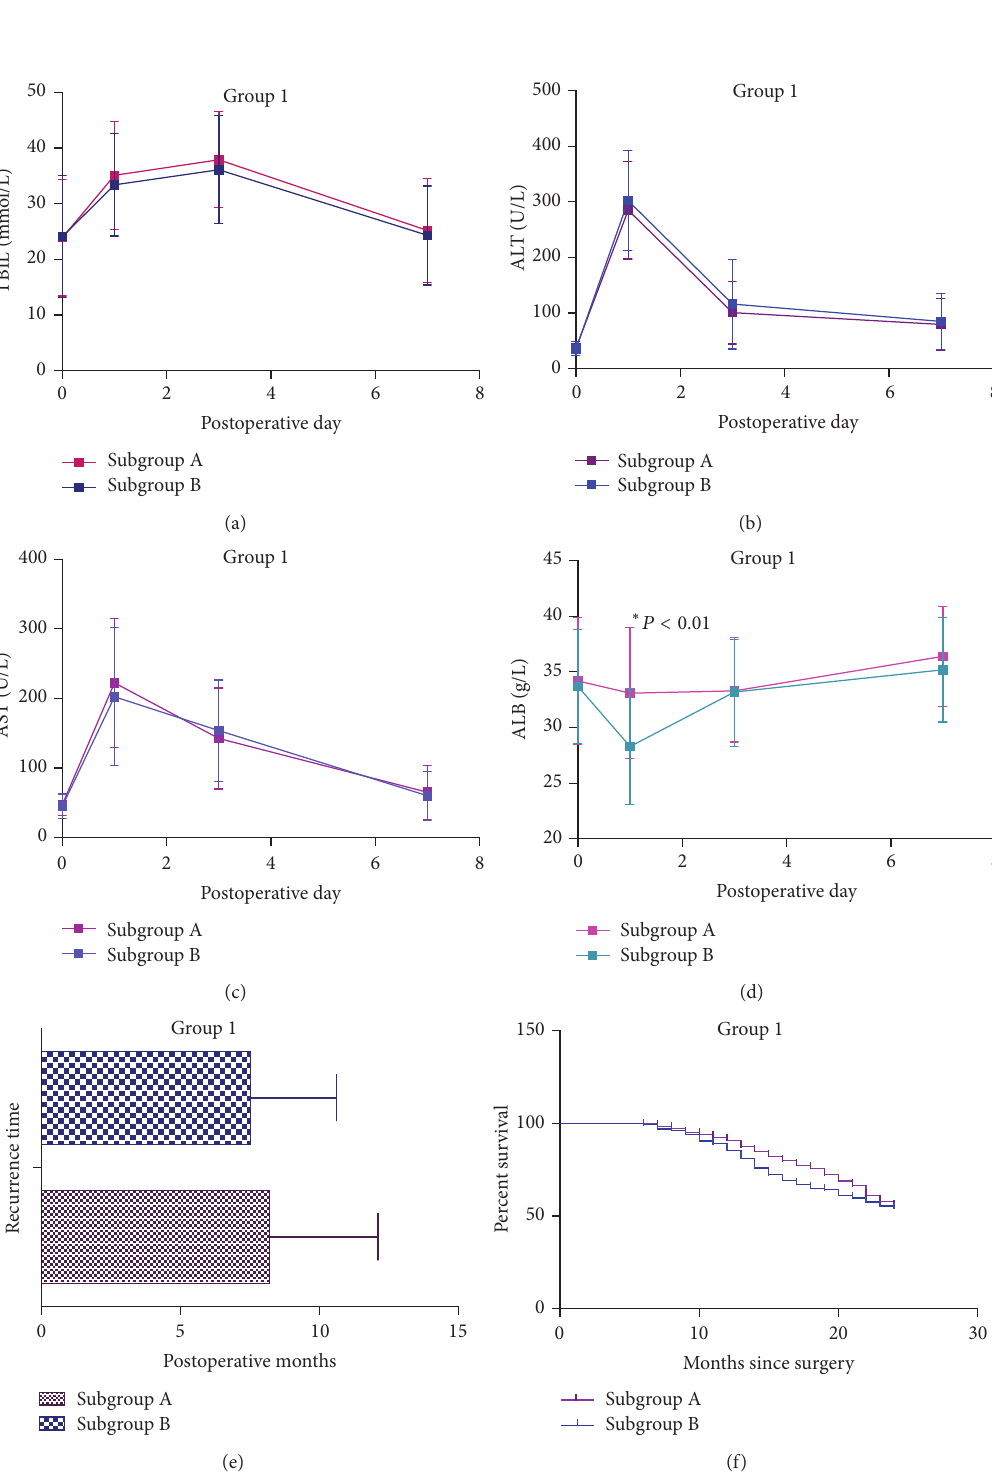
Figure 2: Curves of parametric data for patients in group 1 during the perioperative period and prognosis data. (a) Curves of TBIL levels in group 1 on postoperative days 1, 3, and 7. (b) Curves of ALT levels in group 1 on postoperative days 1, 3, and 7. (c) Curves of AST levels in group 1 on postoperative days 1, 3, and 7. (d) Curves of ALB levels in group 1 on postoperative days 1, 3, and 7. (e) Recurrence time of patients in group 1. (f) Cumulative survival of all included patients in group 1 in the first 24 postoperative